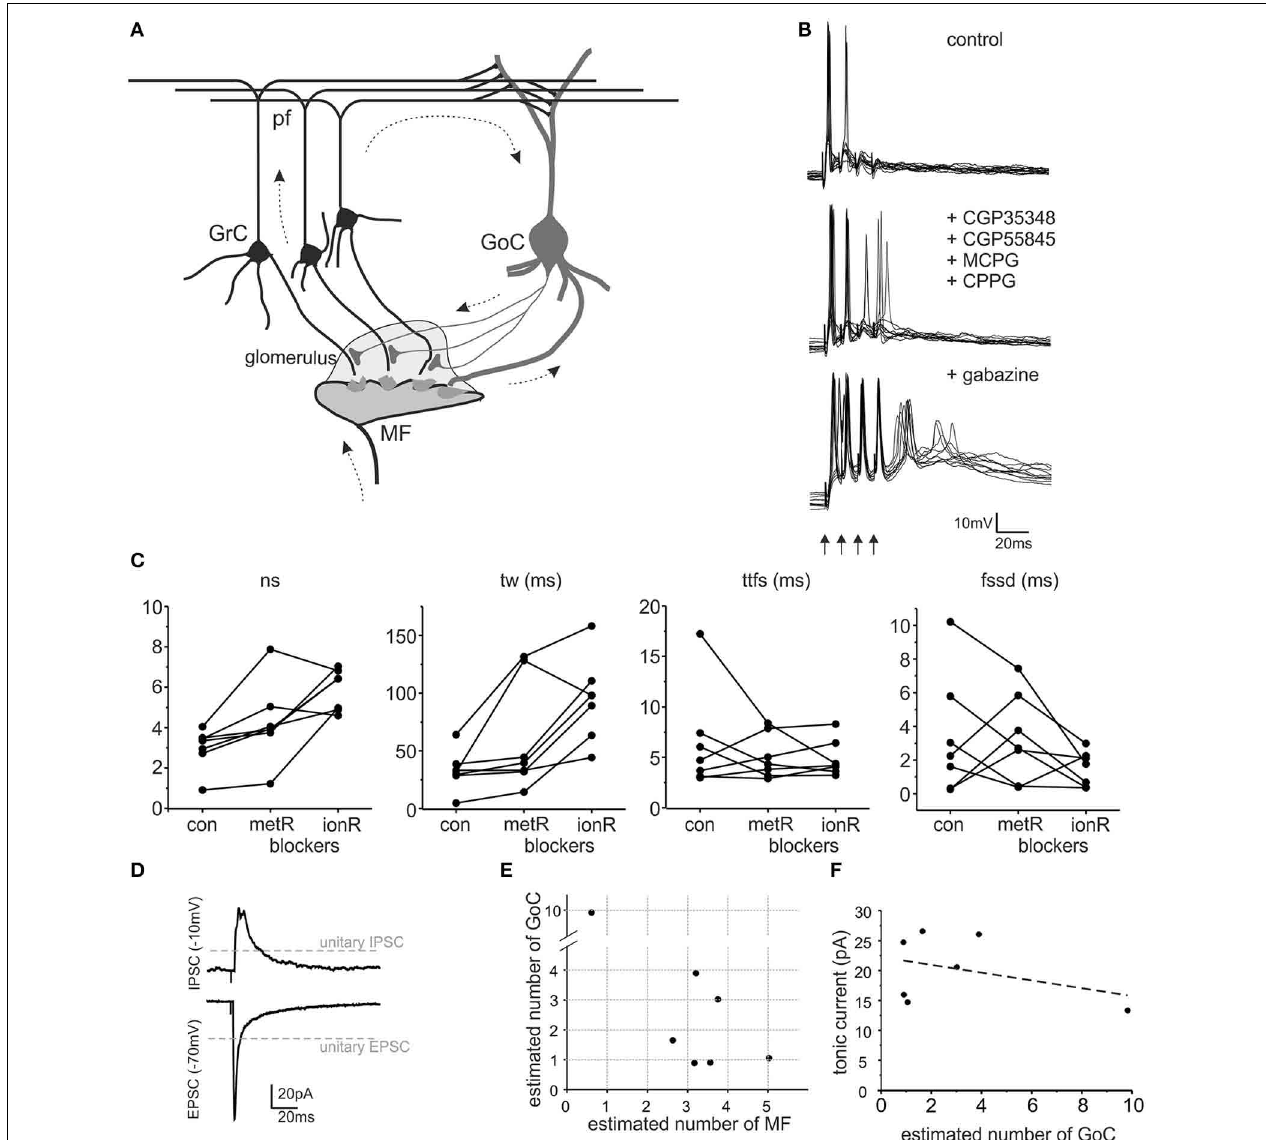
FIGURE 1 | The impact of GABA-A receptors on granule cell excitation. (A) Schematic drawing of the cerebellar glomerulus. The granular layer of the cerebellar cortex receives input from mossy fibers (MF), making synaptic contacts with granule cells (GrC) and Golgi cells (GoC) in specialized structures called glomeruli ( light gray area ). GrC axons (parallel fibers - pf) contact GoC dendrites. Therefore, GoCs inhibit GrCs through a feedforward (MF-GoC-GrC) and a feedback (MF-GrC-GoC-GrC) pathway ( arrows ) (modified from Mapelli et al., 2014). (B) The traces show patch-clamp recordings of GrC activity following a brief burst of MF stimulation (100Hz, arrows ). Glutamatergic and GABAergic metabotropic receptor blockers (MCPG, CPPG, CGP35348, and CGP55845) modify GrC response. The subsequent blockage of ionotropic GABA-A receptors (gabazine) causes an increase in GrC